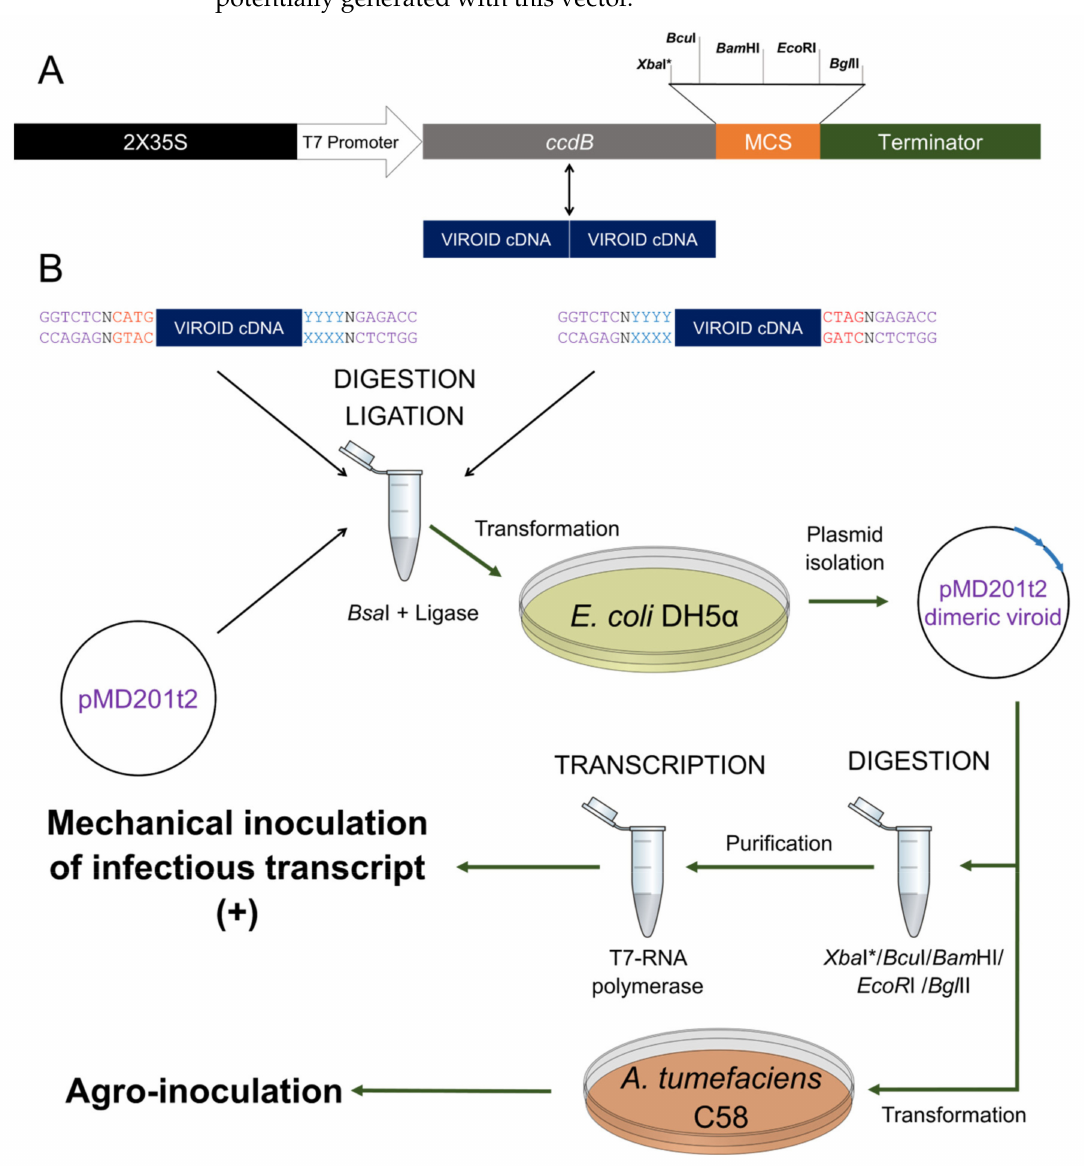
Figure 1. Generation of head-to-tail dimeric viroid cDNAs into pMD201t2. ( A ) Scheme of the transcriptional unit (TU) designed for generating dimeric viroid RNAs in vitro or in vivo by agro-inoculation. This TU which consists of a duplicated 35S followed by a T7 promoter, the lethal gene ccdB and the PoPit terminator preceded by a multiple cloning site (MCS). In the cloning process, the dimeric viroid cDNA sequence replaces the lethal gene, therefore being a highly efficient reaction. ( B ) Viroid sequences are amplified with two pairs of primers containing the Bsa I recognition site (purple) designed to generate compatible ends between the viroid cDNA (blue) and to the plasmid (red). The dimeric viroidal cDNA cloned into pMD201t2 can be used to generate the infectious RNA transcript in vitro, using T7 RNA polymerase onto a linearized plasmid (digested with Bcu I, Bam HI, Eco RI Bgl II, and Xba I*). Additionally, the pMD201t2-viroid can be transformed into Agrobacterium tumefaciens for transient plant transformation and subsequent production of infective viroid RNAs in vivo. * If the viroid cDNA sequence ends in